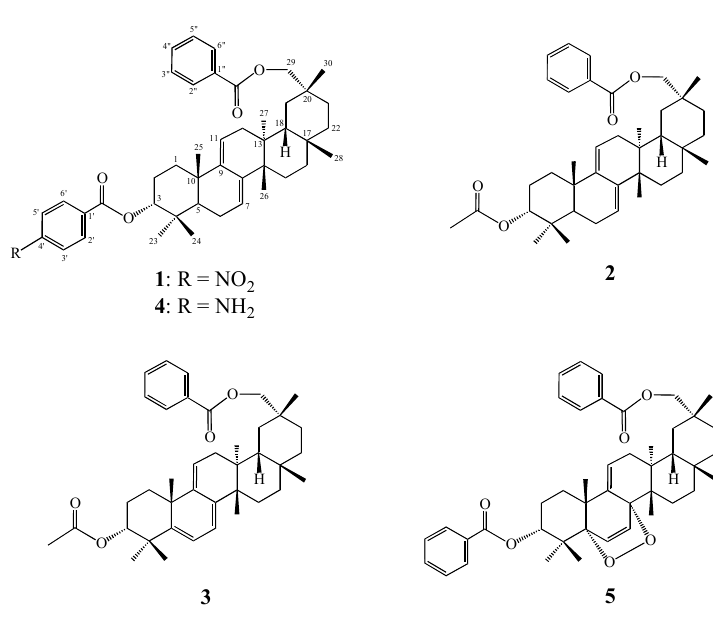
Figure 1. Structures for compounds 1 – 5